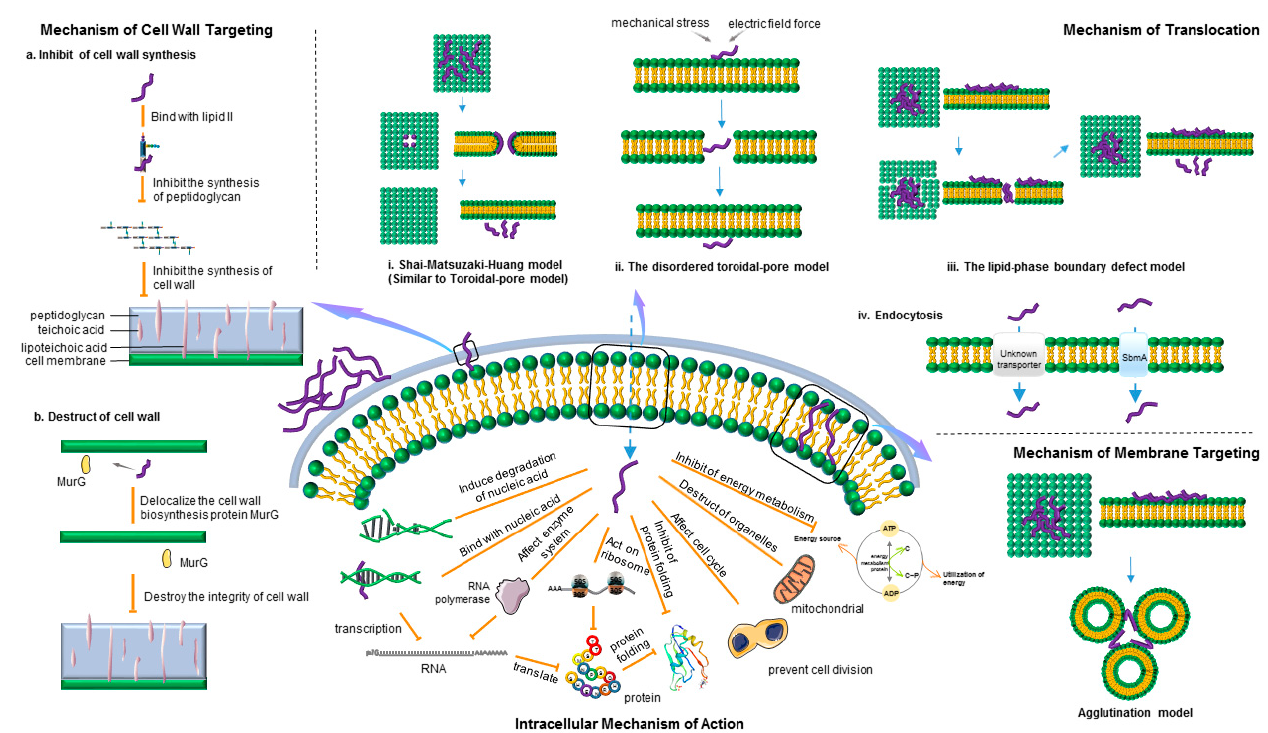
Figure 1. Antimicrobial mechanism of antimicrobial peptides (AMPs). It includes the cell wall–targeting mechanism, membrane-targeting mechanism (only agglutination model is listed), translocation mechanism, and intracellular mechanism of intracellular activity. The blue arrow and yellow line indicate the process, and a short line at the bottom of the yellow line indicates the inhibition (the same below).